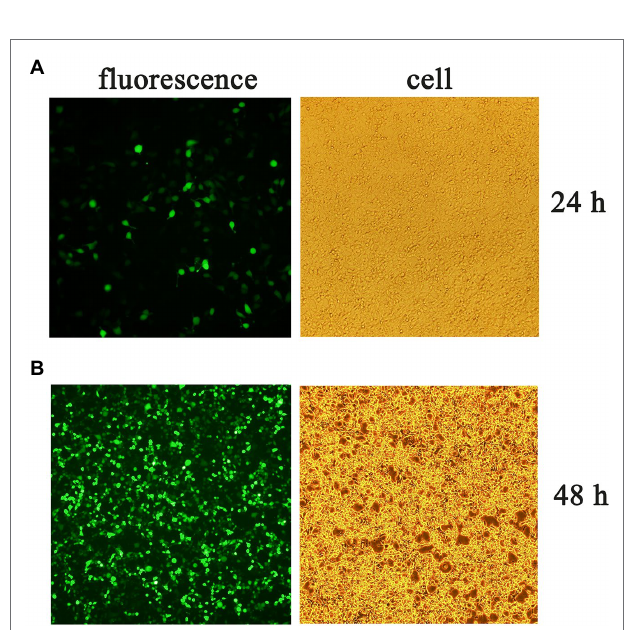
FIGURE 2 | The fluorescence and cells at 24 (A) and 48 h (B) post-